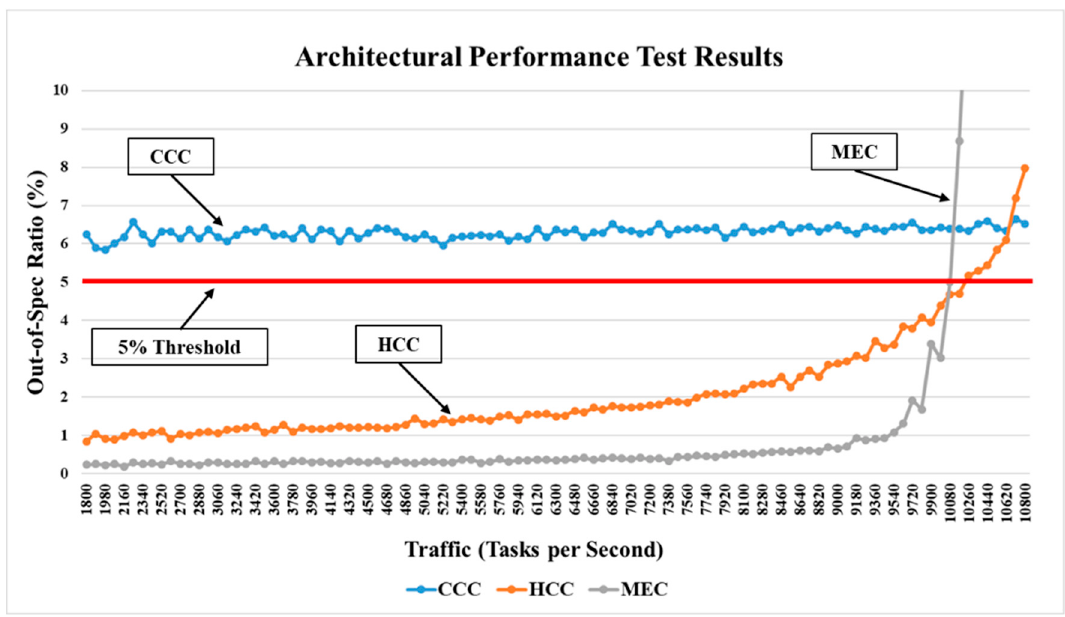
Figure 6. Robustness assessment for CCC, HCC, and MEC architectures.